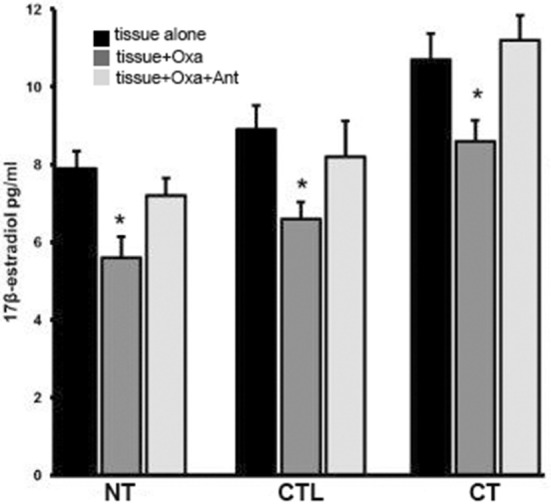
17βE secretion in vitro carried out in normal, cryptorchid, and contralateral dog testis. Testicular slices were incubated with OxA alone or with OxA and the OX1R antagonist SB-408124 and the 17βE level in the media monitored after 12 h. Values are normalized per ml of incubation medium. Data are expressed as mean ± SD (n = 5 samples/group), *p < 0.01.